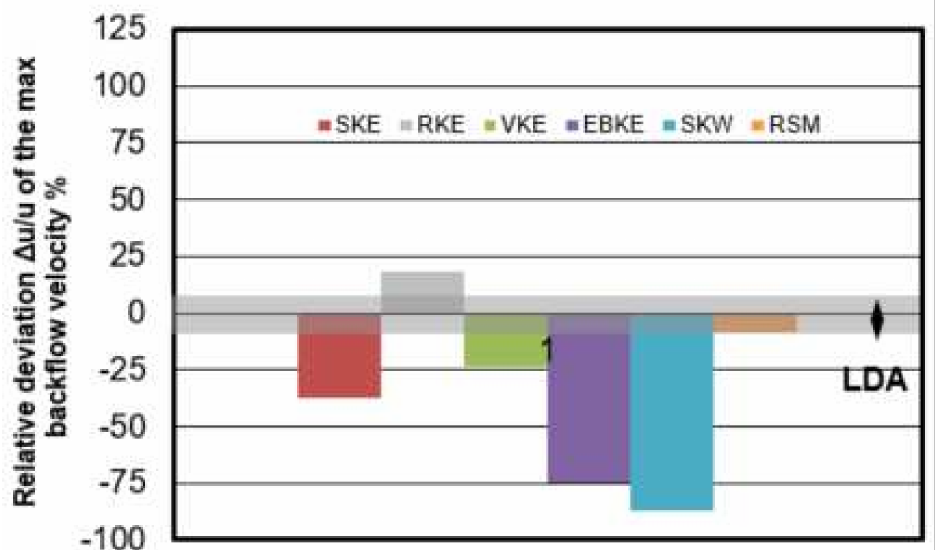
Figure 10. Relative deviation ∆ u/u of the maximum backflow velocity between CFD models with different turbulence